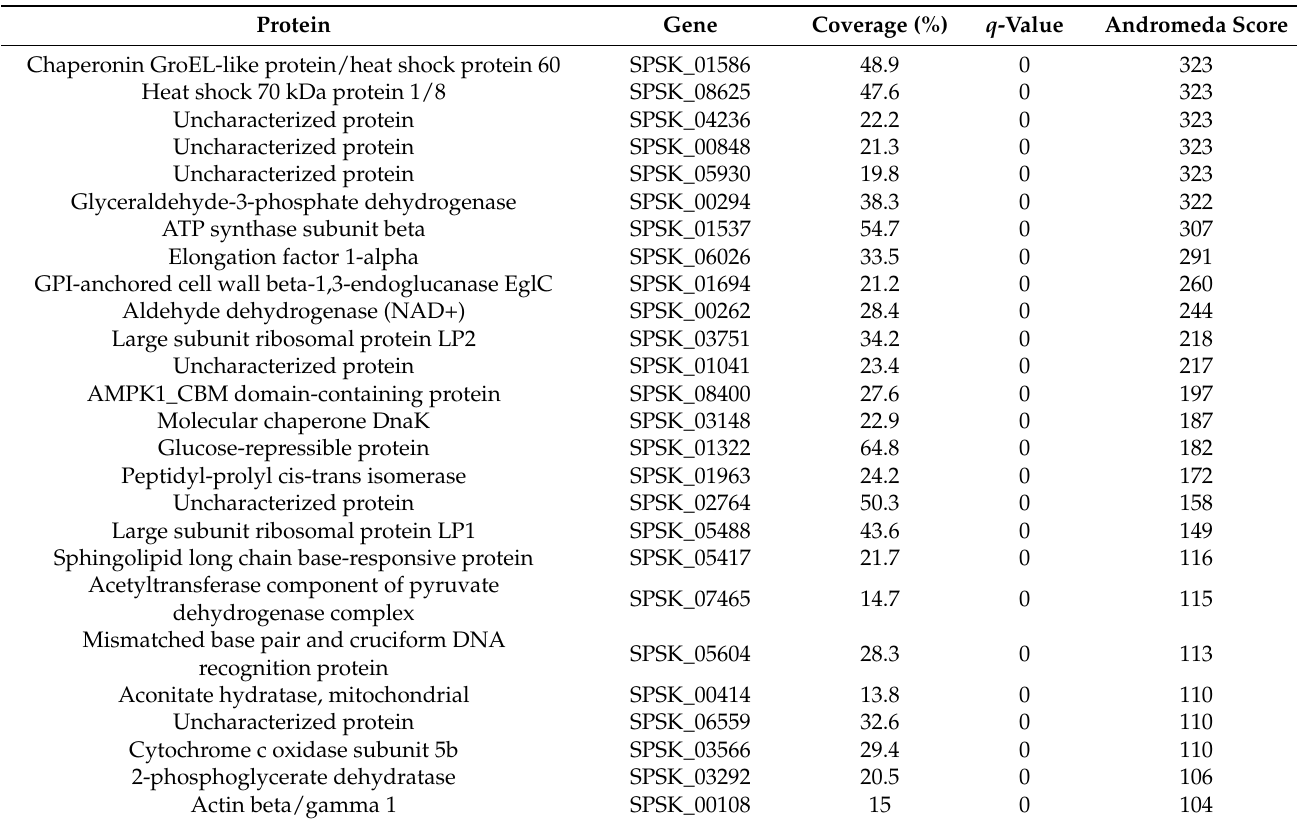
Table 1. Main identified proteins in peptidorhamnomannan by capillary liquid-chromatography-electrospray ionization- quadrupole time-of-flight mass